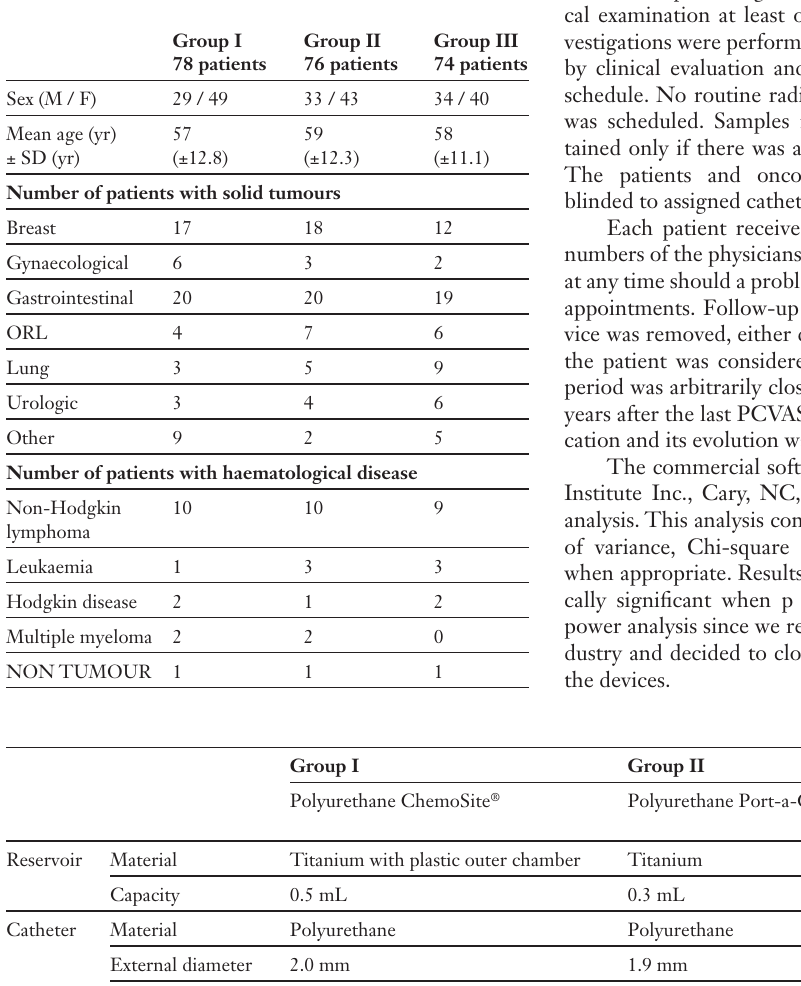
Patients’ demo- graphic data and related disease information.